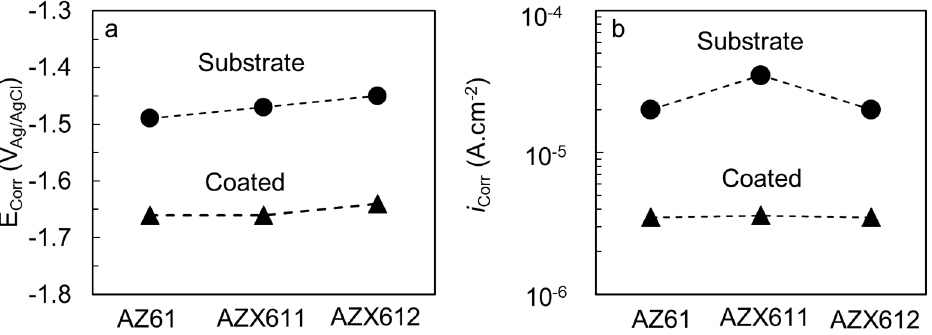
Figure 6. (a ) Corrosion potentials and ( b ) corrosion current densities of the substrates and coated specimens of AZ61, AZX611, and AZX612 alloys.